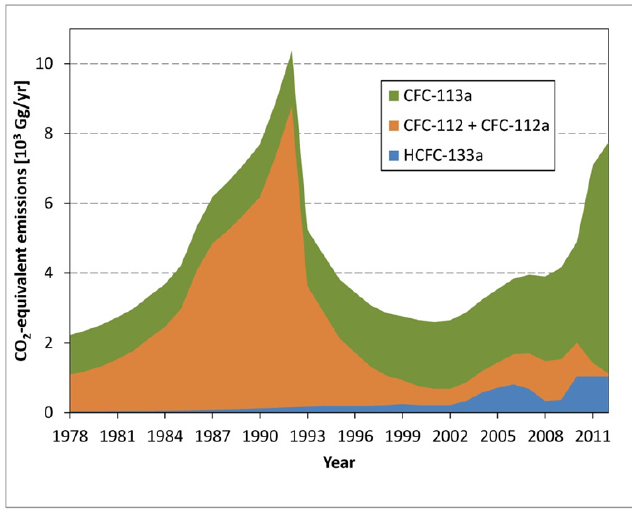
Figure 3. Time series of CO equivalent emissions of the CFC-113a, HFC-133a, CFC-112 2 and CFC-112a, using the emission values in [1] and the GWP (100) values given in Table